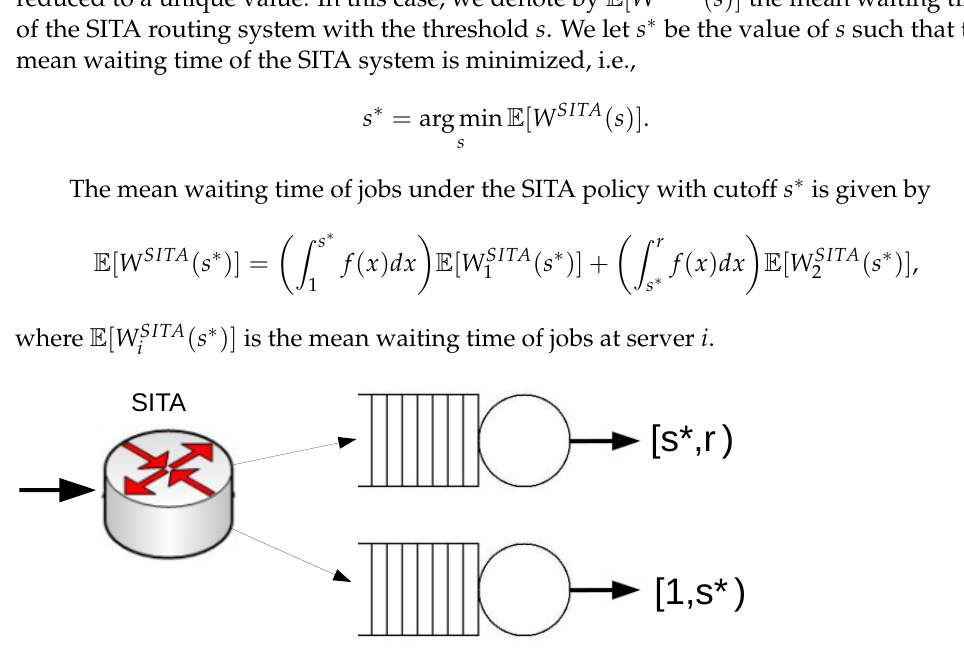
Figure 2. A system with two servers that operates under Size Interval Task Assignment